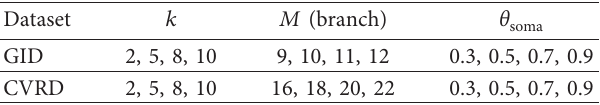
Table 5: Simulation parameter levels for two benchmark datasets in the EDNM.